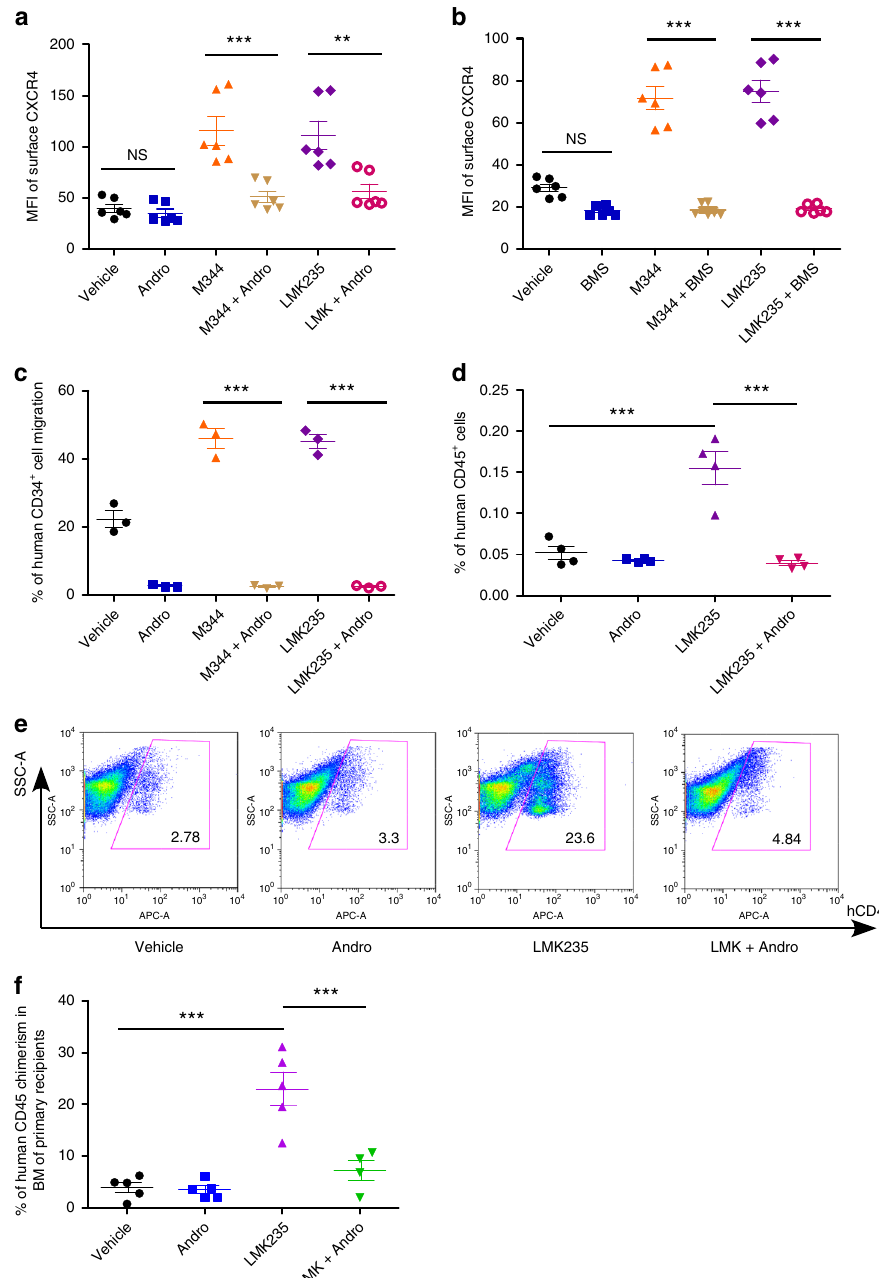
Fig. 7 NF- κ B signaling pathway is involved in HDAC5-mediated CB HSC homing. a Mean fl uorescence intensity (MFI) of surface CXCR4 in vehicle, Andrographolide (Andro, 10 μ M), M344-, M344 + Andro-, LMK235-, LMK235 + Andro-treated human CB CD34 + cells, as assessed by fl ow cytometry. Data pooled from three independent experiments are shown ( n = 6, one-way ANOVA, ** p < 0.01, *** p < 0.001, NS indicates p > 0.05). b Mean fl uorescence intensity (MFI) of surface CXCR4 in vehicle, BMS345541 (BMS, 10 μ M), M344-, M344 + BMS-, LMK235-, LMK235 + BMS-treated human CB CD34 + cells, as assessed by fl ow cytometry. Data pooled from three independent experiments are shown ( n = 6, one-way ANOVA, *** p < 0.001, NS indicates p > 0.05). c The cells were cultured in the presence of vehicle, Andrographolide (Andro, 10 μ M), M344, M344 + Andro-, LMK235, or LMK235 + Andro for 16 h and then allowed to migrate toward 50 ng/mL SDF-1 for 4 h. Data pooled from three independent experiments are shown ( n = 3, one-way ANOVA, *** p < 0.001). d The percentage of human CD45 + cells in the BM of NSG mice 24 h after transplantation with 500,000 CB CD34 + cells that had been treated with vehicle, Andrographolide (Andro, 10 μ M), LMK235, or LMK235 + Andro. Data pooled from four independent experiments are shown ( n = 4 mice per group, one-way ANOVA, *** p < 0.001). e Representative fl ow cytometric analysis of human engraftment in the BM of NSG mice transplanted with human CB CD34 + cells treated with vehicle control, Andrographolide (Andro), LMK235, or LMK235 + Andro for 16 h. Human engraftment was assessed as the percentage of human CD45 + cells. f The percentage of human CD45 + cell chimerism in the BM of NSG mice after transplantation with 10,000 CB CD34 + cells that had been treated with vehicle control, Andrographolide (Andro), LMK235, or LMK235 + Andro for 16 h ( n = 4 – 5 mice per group, one-way ANOVA, *** p < 0.001). For all panels, data are shown as dot plots (mean ±